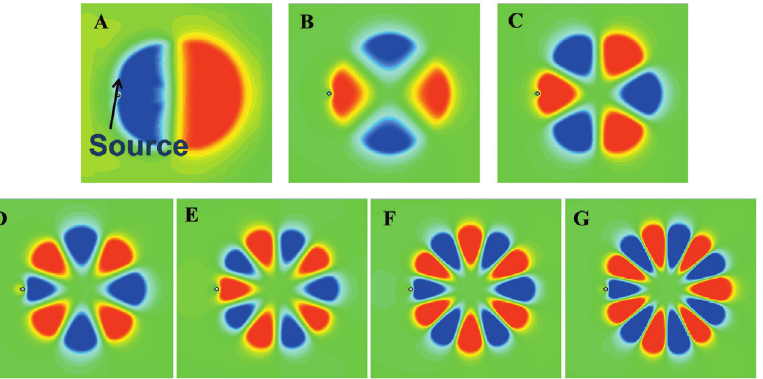
Figure 22: The simulated near-field patterns of vertical electric fields on a plane 0.5 mm above the textured metallic disk. (A) The dipole mode (M ) at 4.75 GHz; (B) quadrupole mode (M 1 (E) decapole mode (M ) at 8.01 GHz; (F) dodecapole mode (M 5 [46] with